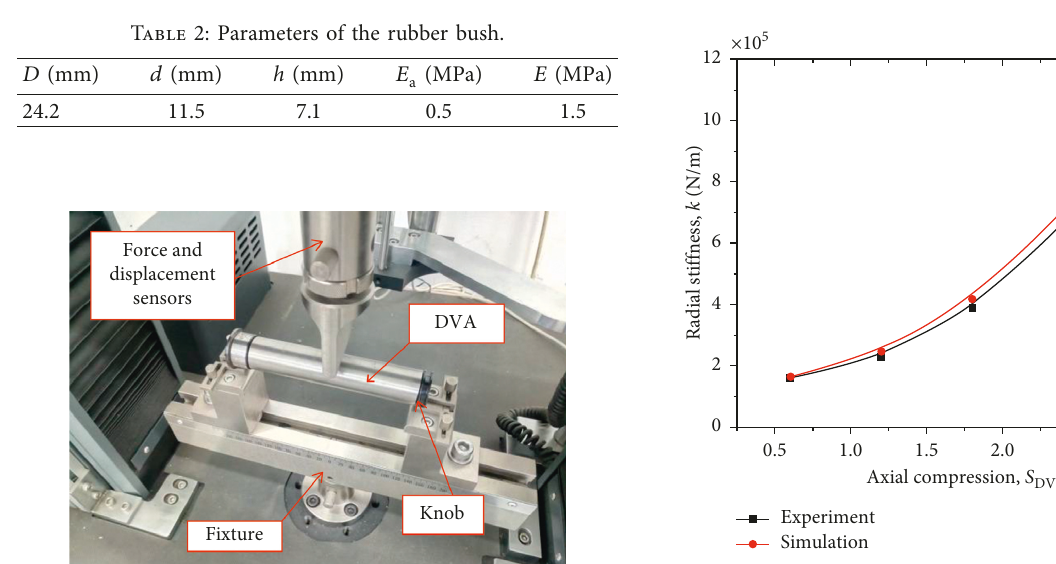
Figure 15: Experiment and simulation results of the stiffness of the